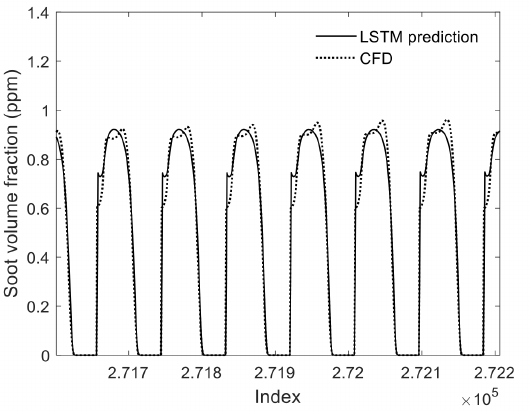
Figure 10. LSTM and CFD predictions of f v over a select range of the spatiotemporal